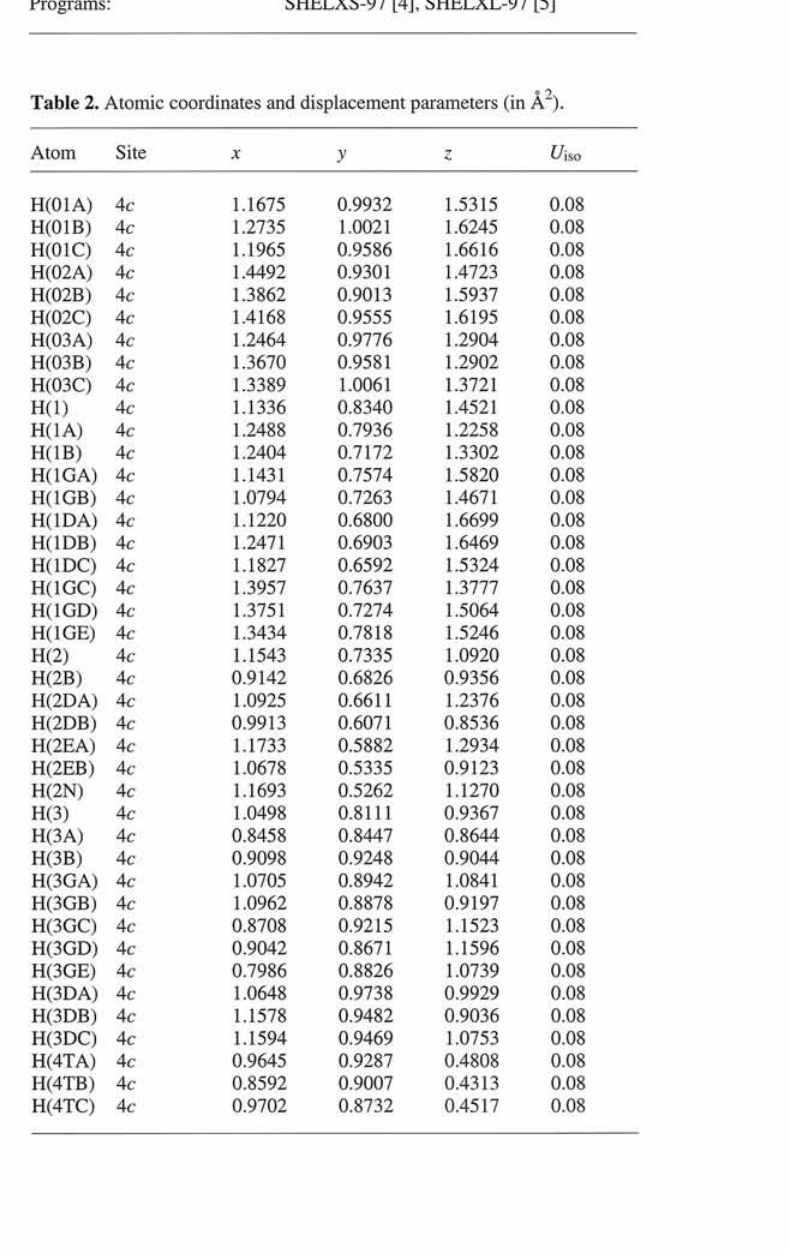
Table 2. Atomic coordinates and displacement parameters (in